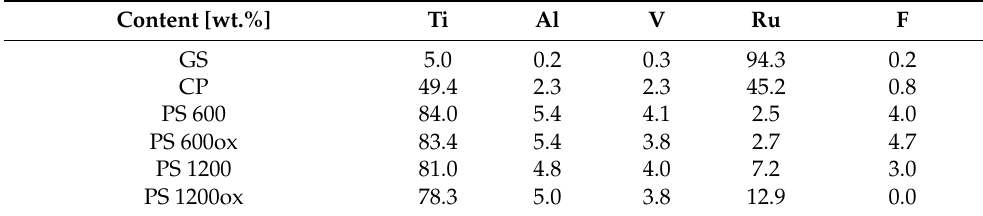
Table 2. Results of EDS analysis of prepared samples.